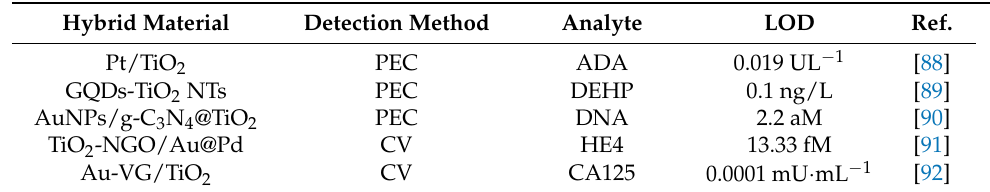
Table 3. Shows some TiO 2 -inorganics used in biosensor